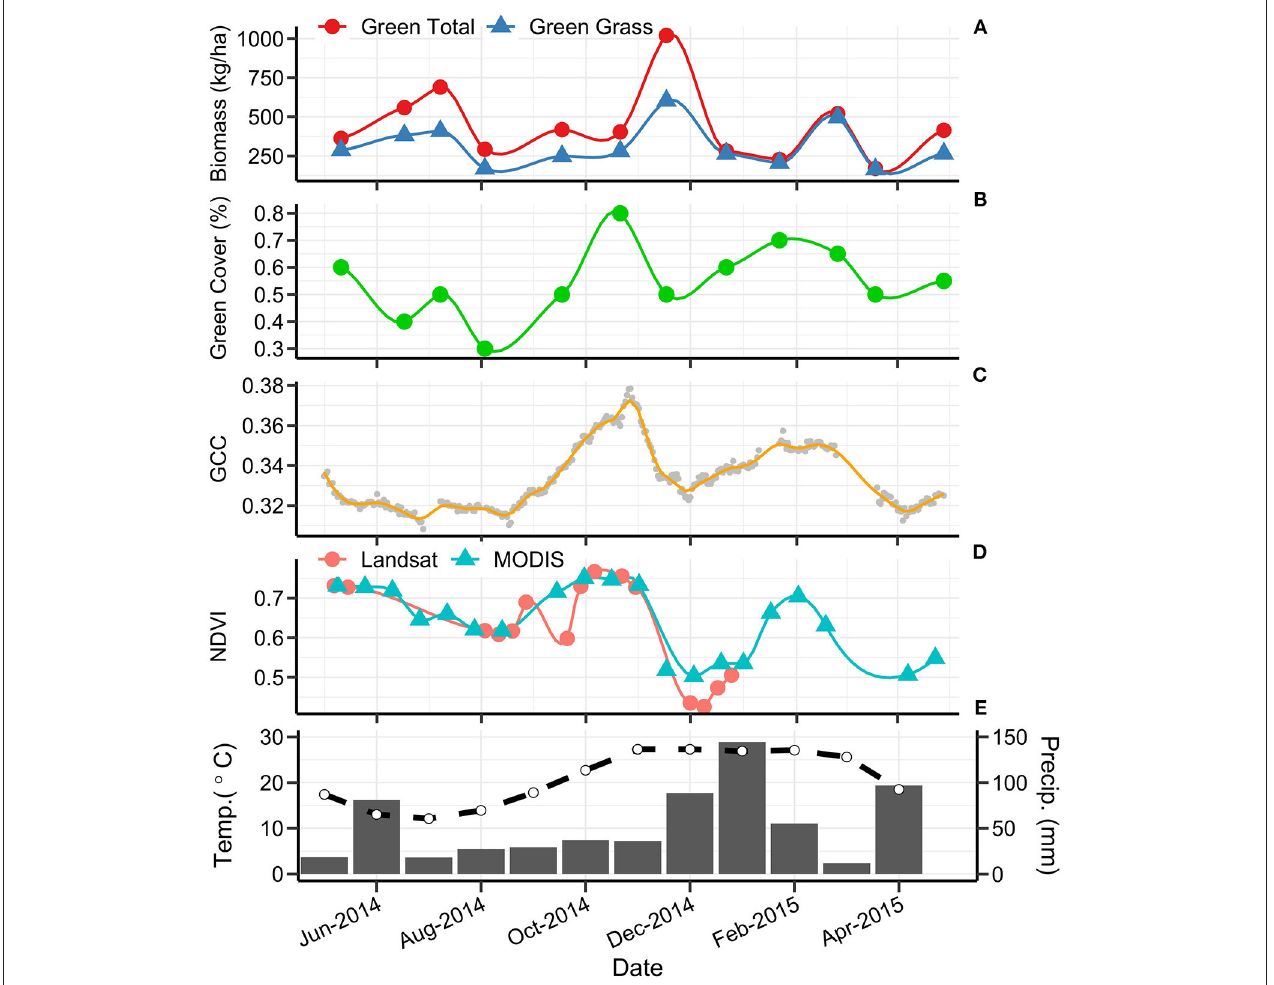
FIGURE 9 | Multi-scale phenology from 1 May 2014 to 30 April 2015 at site MULN (C 3 Native). From top to bottom panel: (A) total green biomass (•) and green grass biomass ( N ) in kg/ha; (B) green cover (%); (C) phenocam 13:00 daily g CC ; (D) Terra MODIS ( N ) and Landsat OLI/ETM + (•) NDVI; (E) monthly mean maximum temperature ( ◦ C; dashed line; Tuggeranong Bureau of Meteorology station) and the monthly rainfall (mm; solid bars; Australian National Botanic Gardens Bureau of Meteorology